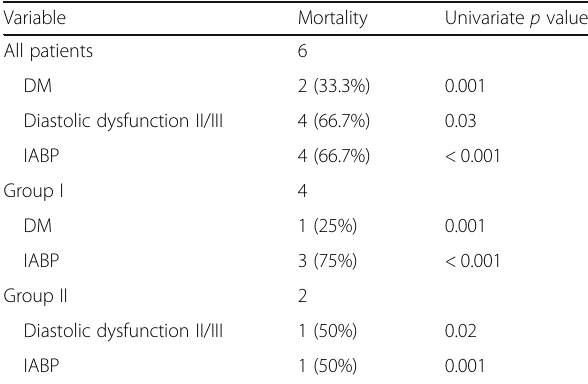
DM diabetes mellitus, IABP intra-aortic balloon